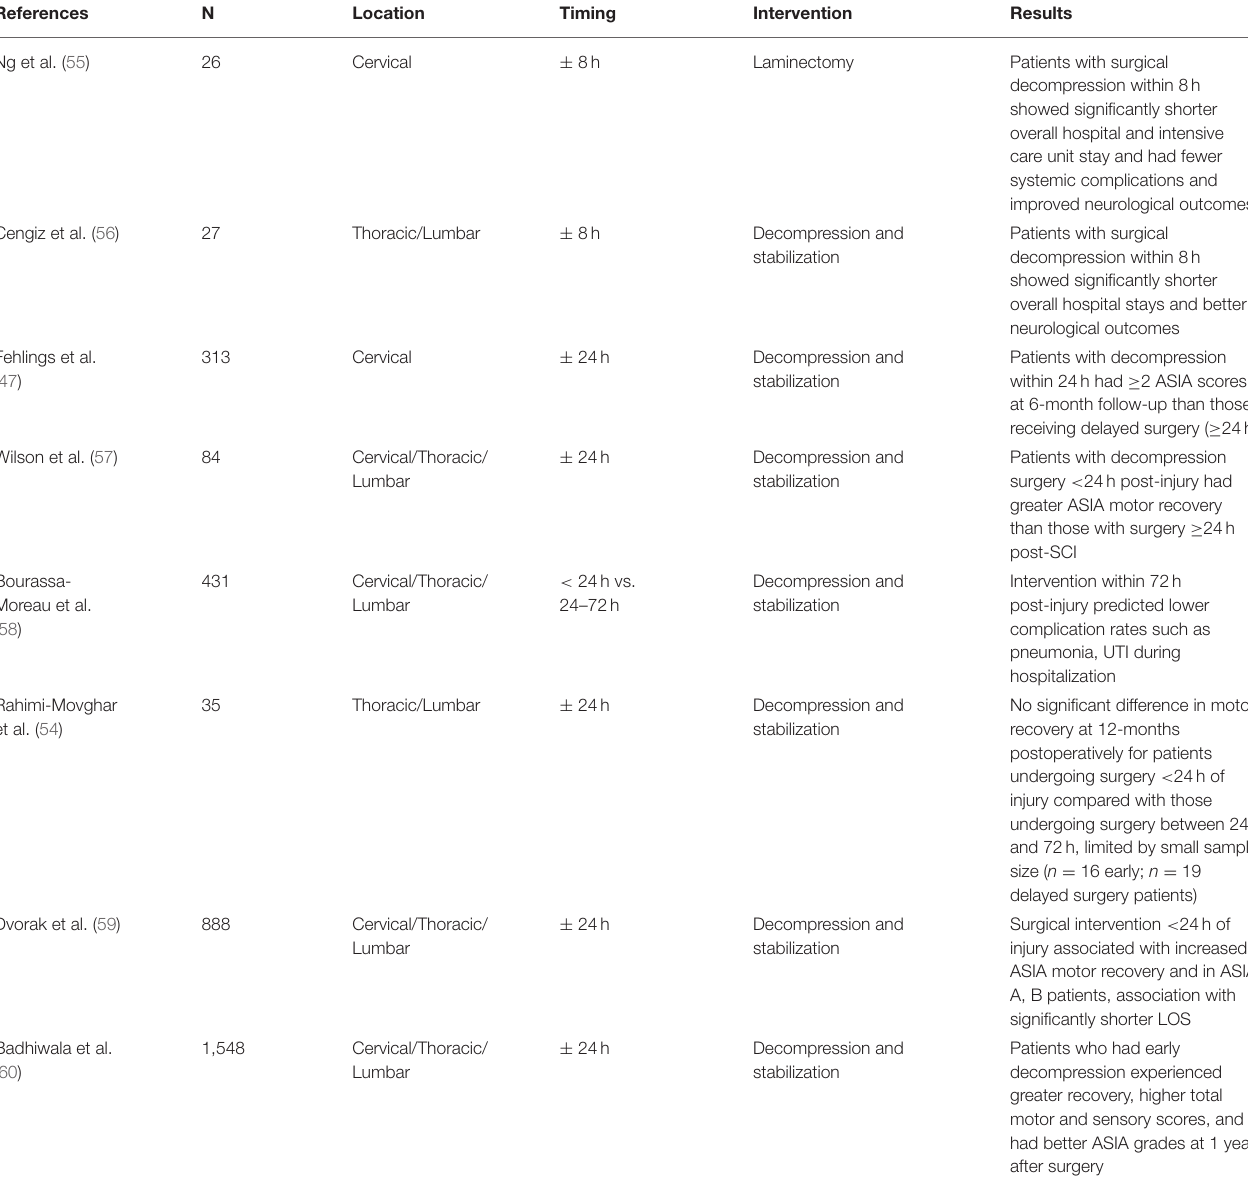
TABLE 4 | Summary of relationship between timing of surgery and clinical outcomes in patients with spinal cord